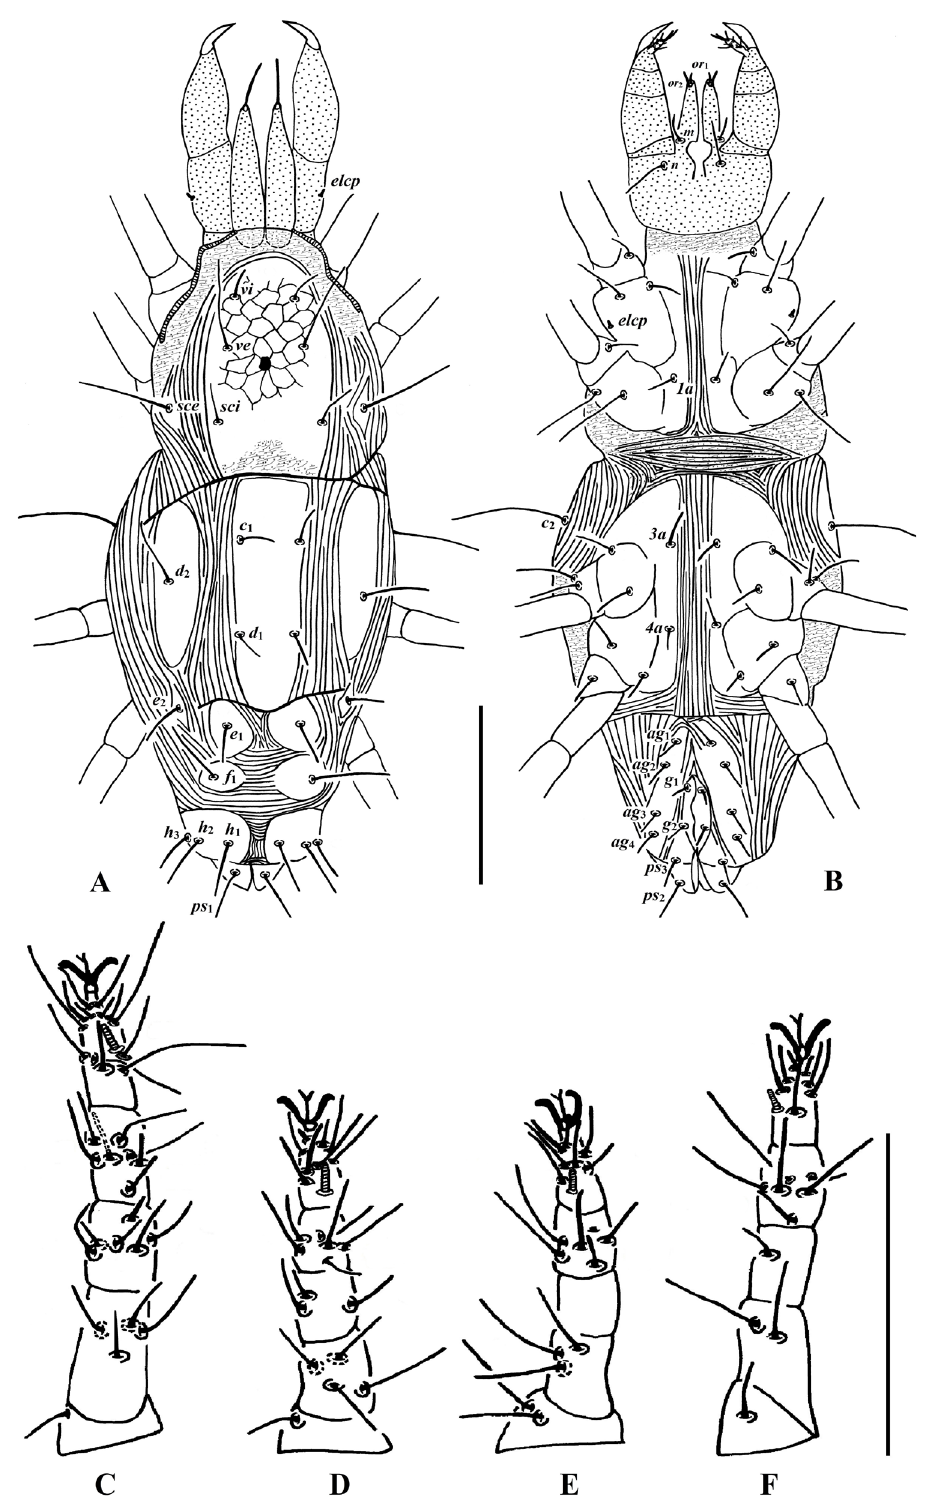
Fig. 3. Stigmaeus miandoabiensis Bagheri & Zarei, 2012 (♀). A . Dorsum of body. B . Venter of body. C . Leg I. D . Leg II. E . Leg III. F . Leg IV. Scale bars = 100